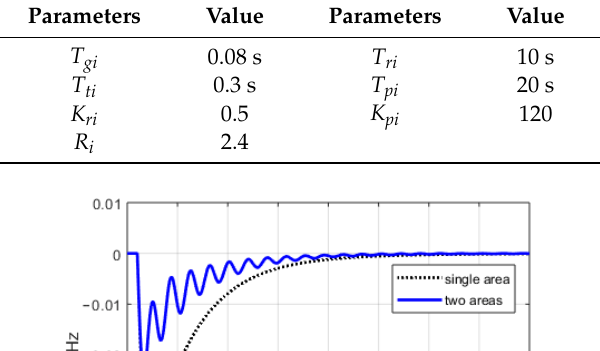
Table 1. Basic parameters of the regional load frequency control (LFC) model for reheat steam turbine unit.